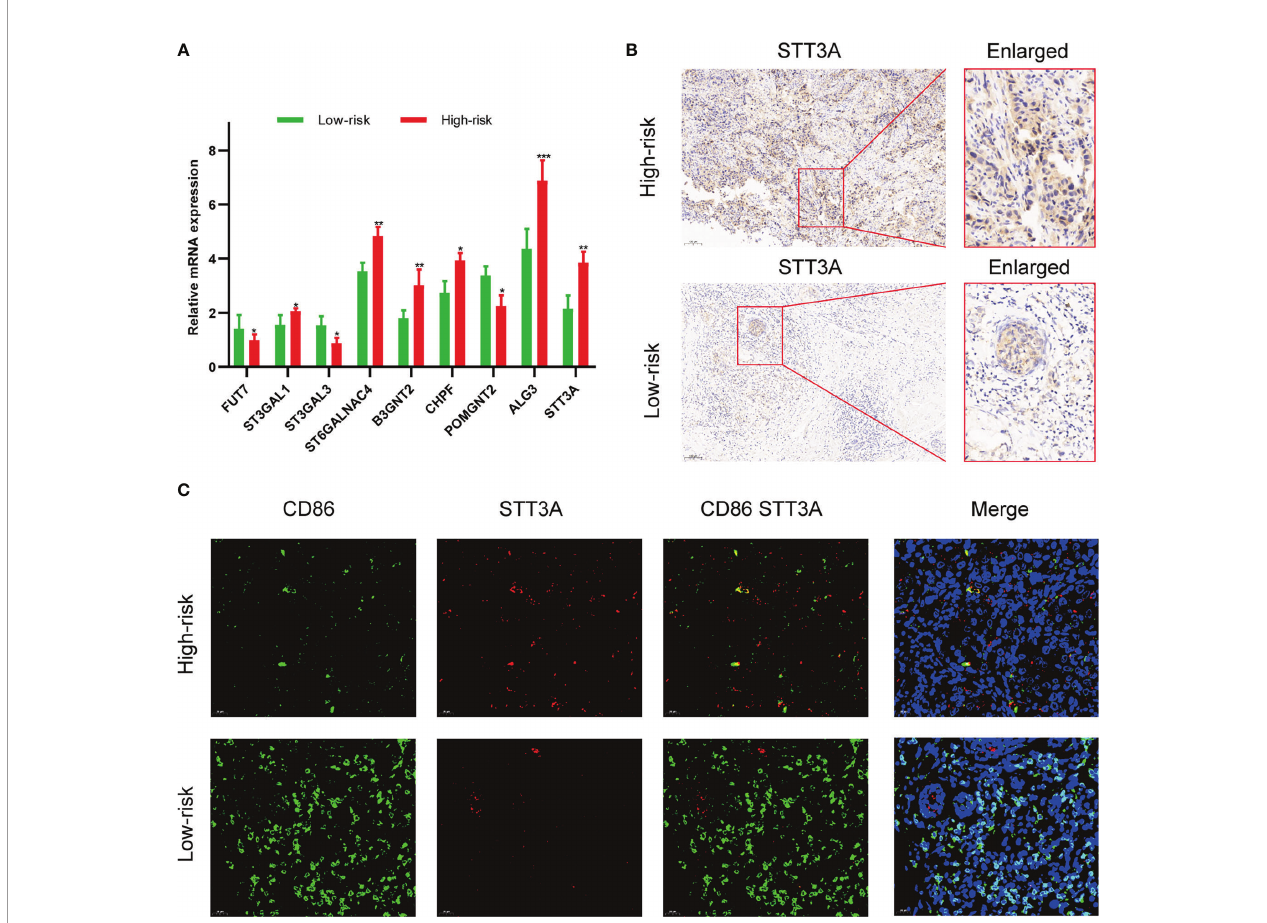
FIGURE 11 | Validation of the association between glycosyltransferase and tumor microenvironment in a clinical cohort. (A) Expression of glycosyltransferase genes in the high-risk group and low-risk group. (B) STT3A was overexpressed in the high-risk group patient. (C) The antitumoral M1 macrophage marker was increased in the low-risk group accompanied by decreased STT3A. *p < 0.05, **p < 0.01, ***p <